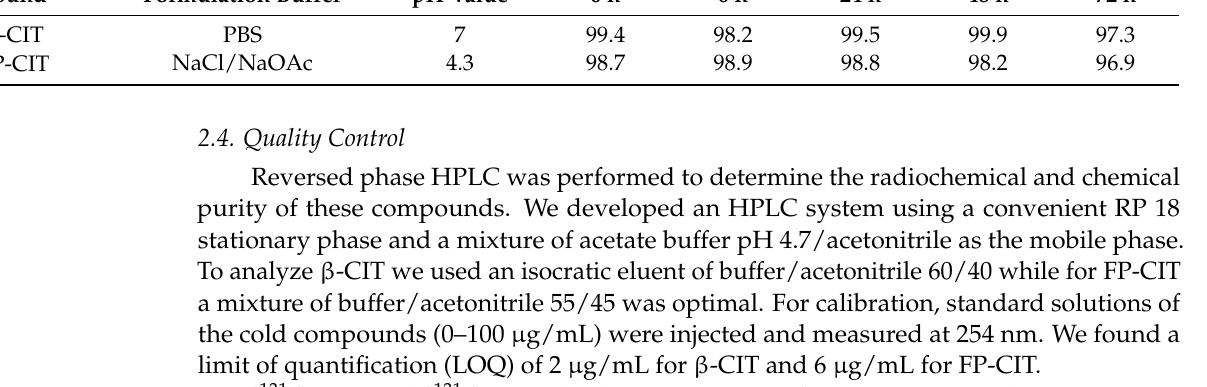
Table 2. Stability data of [ 131 I] β -CIT ( n = 3) and [ 131 I]FP-CIT ( n = 3). Product